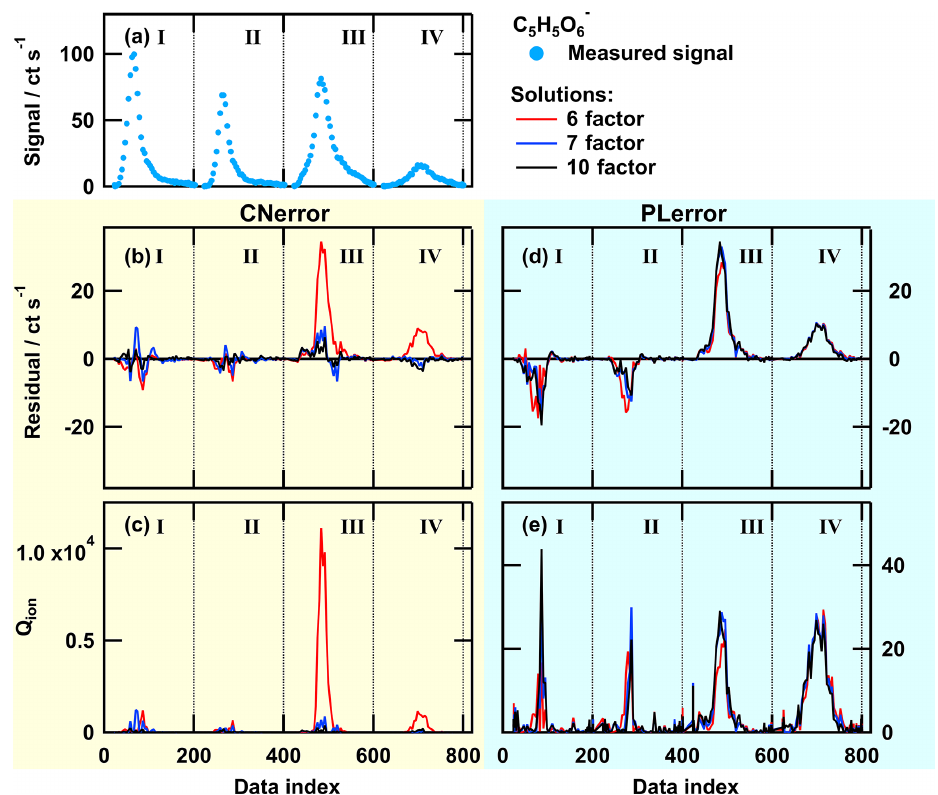
Figure A1. Single ion thermogram (a) , residual (b, d) , and Q ion values (c, e) as time series for solutions with 6, 7, or 10 factors for PMF run with CNerror (b, c) and PLerror (d, e) for the ion C 5 H 5 O − . The data set contains thermogram scans for high-O : C SOA particles for the 6 following sampling conditions: dry – t evap = 0 . 25h (I); dry – t evap = 4 (II); wet – t evap = 0 . 25h (III); and wet – t evap = 4h (IV). Note that the y scaling is the same in panels (b) and (d) , but it is much smaller in (e) than in (c)